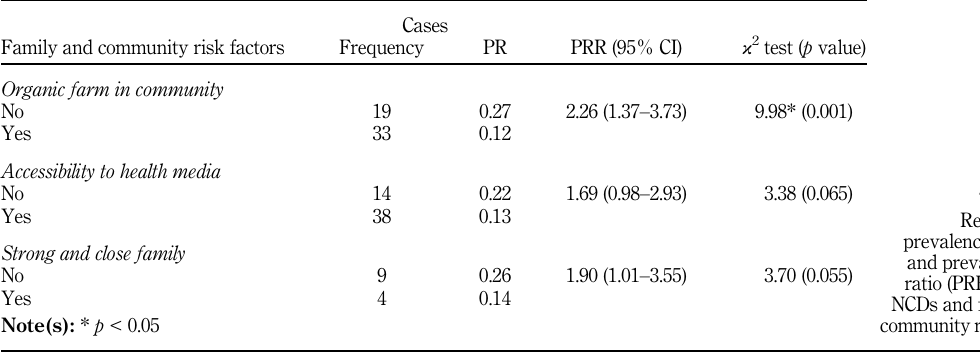
Table IV. Relationship, prevalence rate (PR) and prevalence rate ratio (PRR) between NCDs and family and community risk